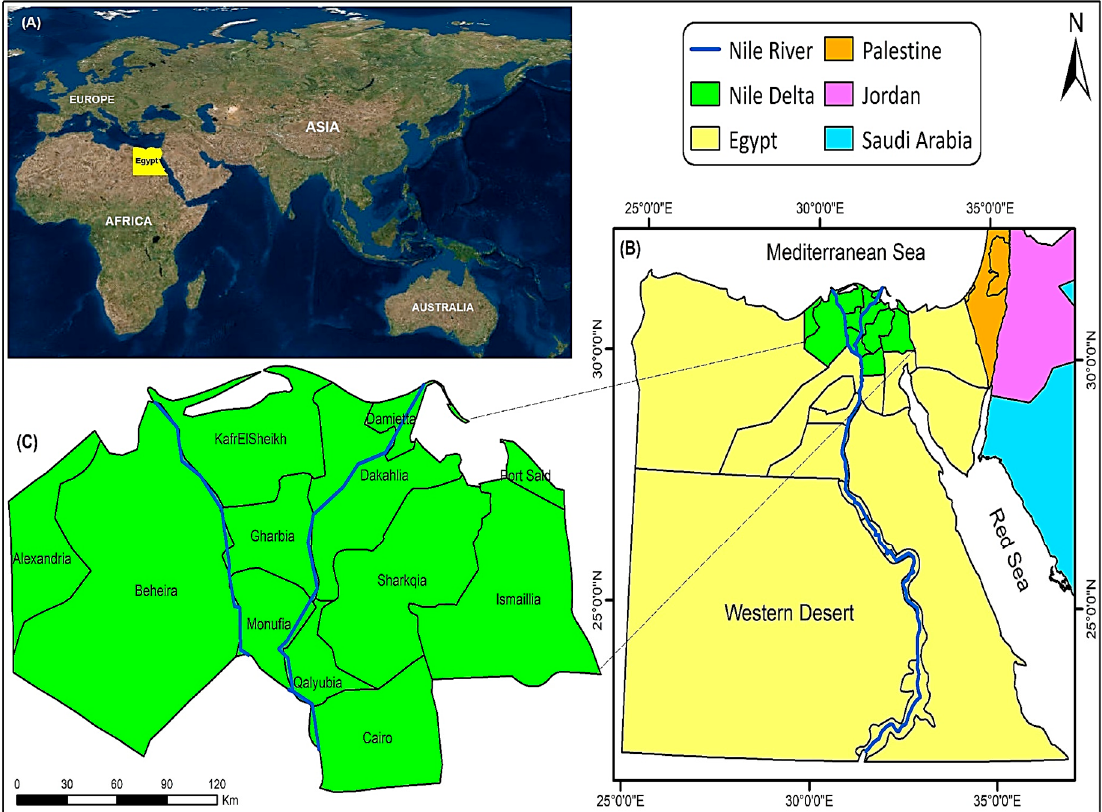
Figure 1. Location of the study area: ( A ) location of Egypt in the North of Africa; ( B ) location of the Nile Delta in the North of Egypt; ( C ) the study area (Nile Delta governorates).